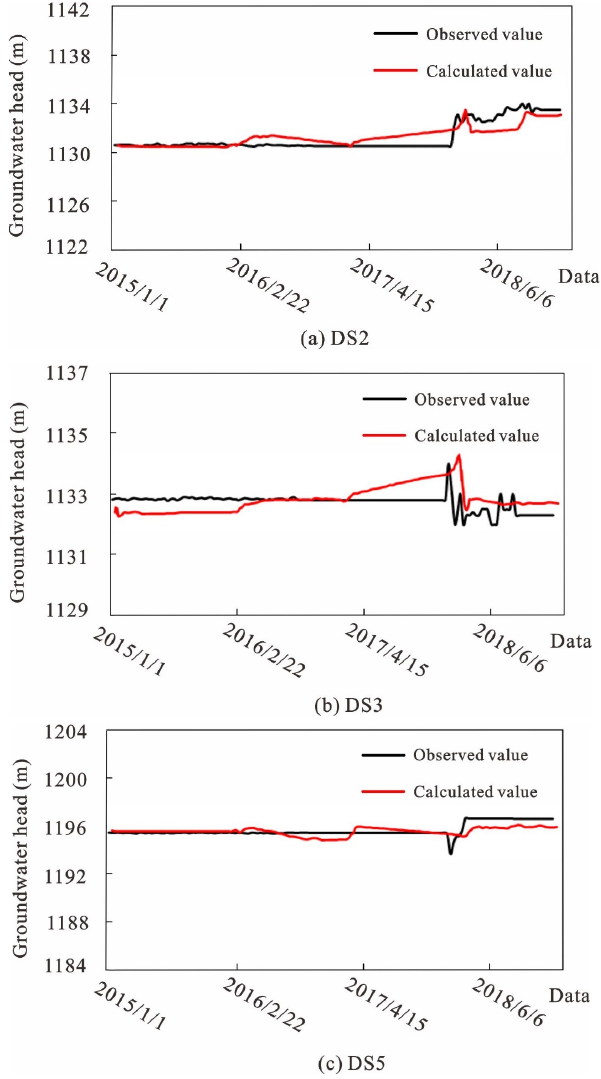
Figure 7. Comparison curves between observed and calculated groundwater levels: ( a ) DS2, ( b ) DS3, ( c ) DS5.